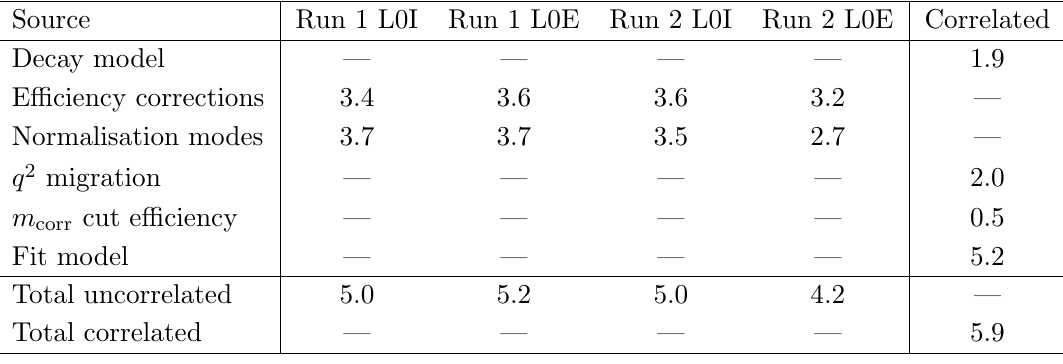
Table 4. Systematic uncertainties in percent associated to the measurement of R (cid:0) 1 di(cid:11)erent data taking periods and trigger categories. For uncertainties that are correlated between data taking periods and categories, a single value is given. LHCb [46] (cid:12) (cid:0) B ( (cid:3) 0 ! pK (cid:0) (cid:22) + (cid:22) (cid:0) ) = 2 : 65 (cid:6) 0 : 14 (cid:6) 0 : 12 (cid:6) 0 : 29 +0 : 38 (cid:12) b 0 : 1 <q 2 < 6 GeV 2 =c 4